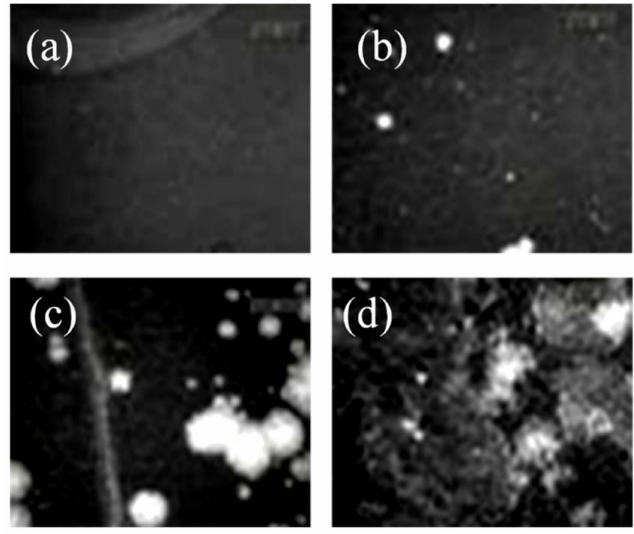
Figure 5. BAM images (width: 500 µ m) of the 4a compound at different surface pressures: ( a ) 0.5 mN ¨ m ´ 1 ; ( b ) 3.0 mN ¨ m ´ 1 ; ( c ) 7.0 mN ¨ m ´ 1 ; and ( d ) 14.0 mN ¨ m ´ 1